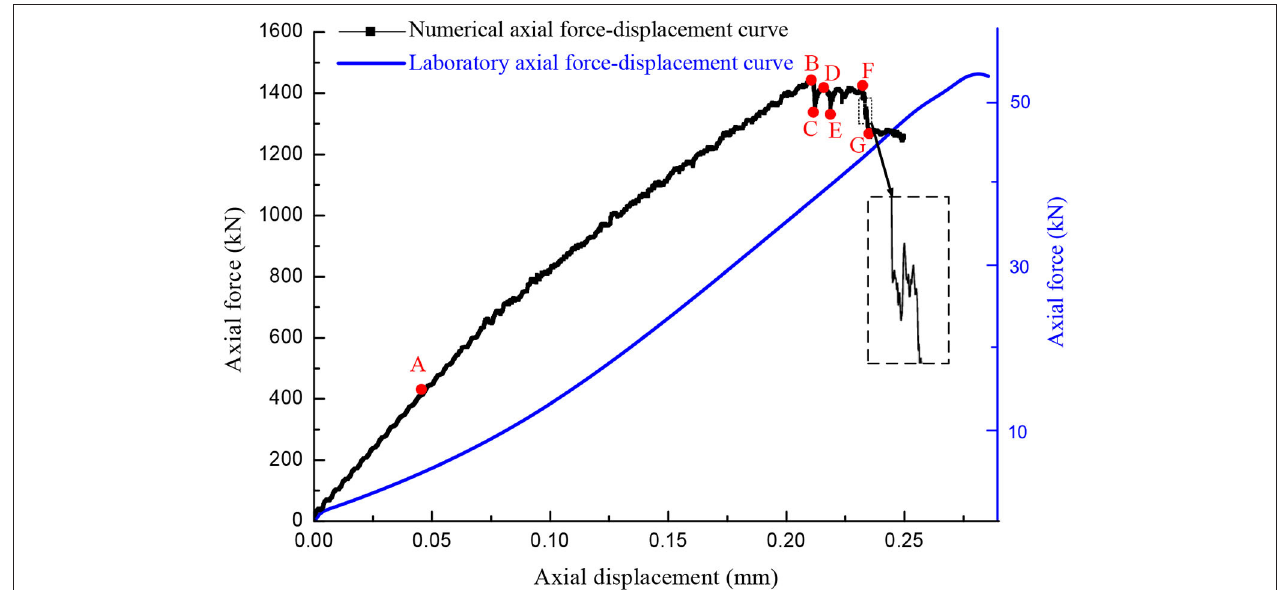
FIGURE 4 | Numerical and laboratory [6] axial compression forces and the monitor points on the numerical curve.